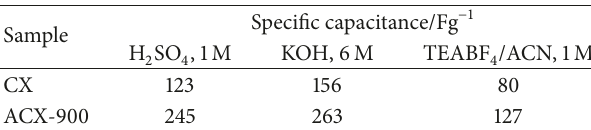
Table 3: Specific capacitance of the CX and ACX-900 electrodes in inorganic and organic electrolytes determined by cyclic voltamme- try at a scan rate of 10mVs −1